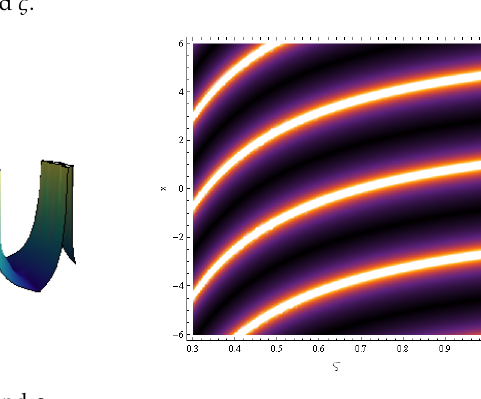
Figure 3. Variation of solution (15) versus x and ς .